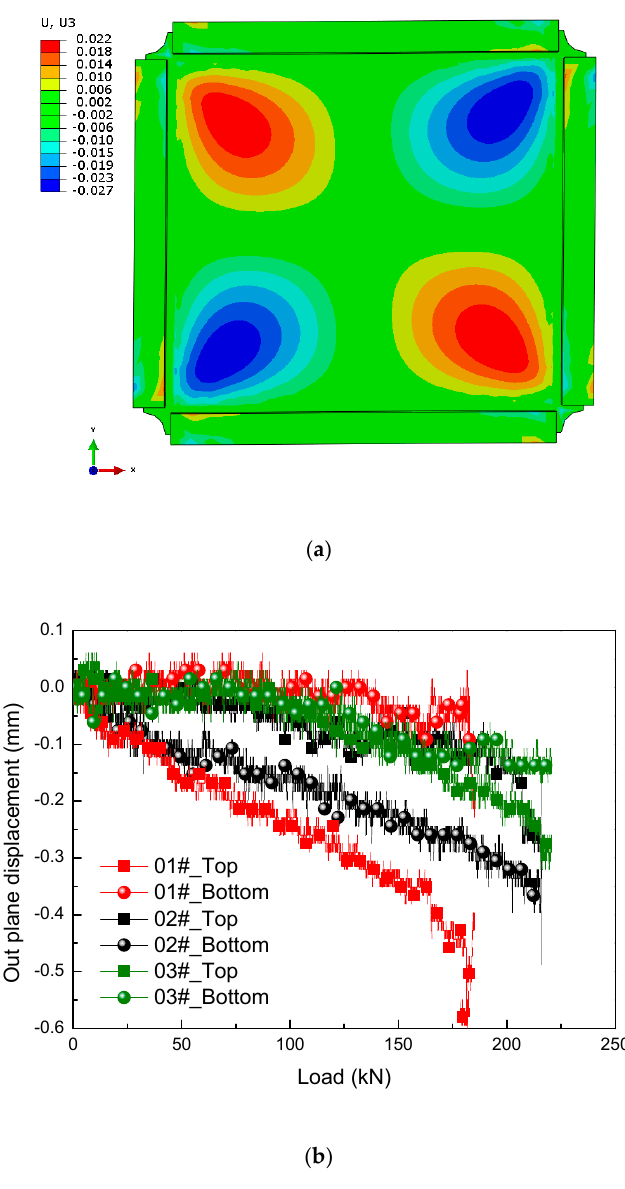
Figure 19. Out-of-plane displacement: ( a ) out-of-plane displacement field distribution obtained by finite element methods (FEM); ( b ) displacement vs. load curves recorded by experiment.